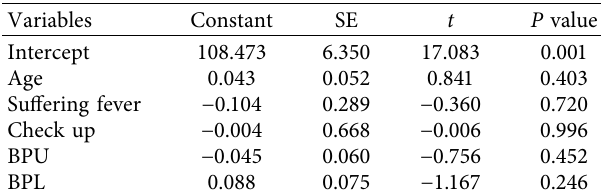
Figure 1: Data are normal. Table 2: Multiple